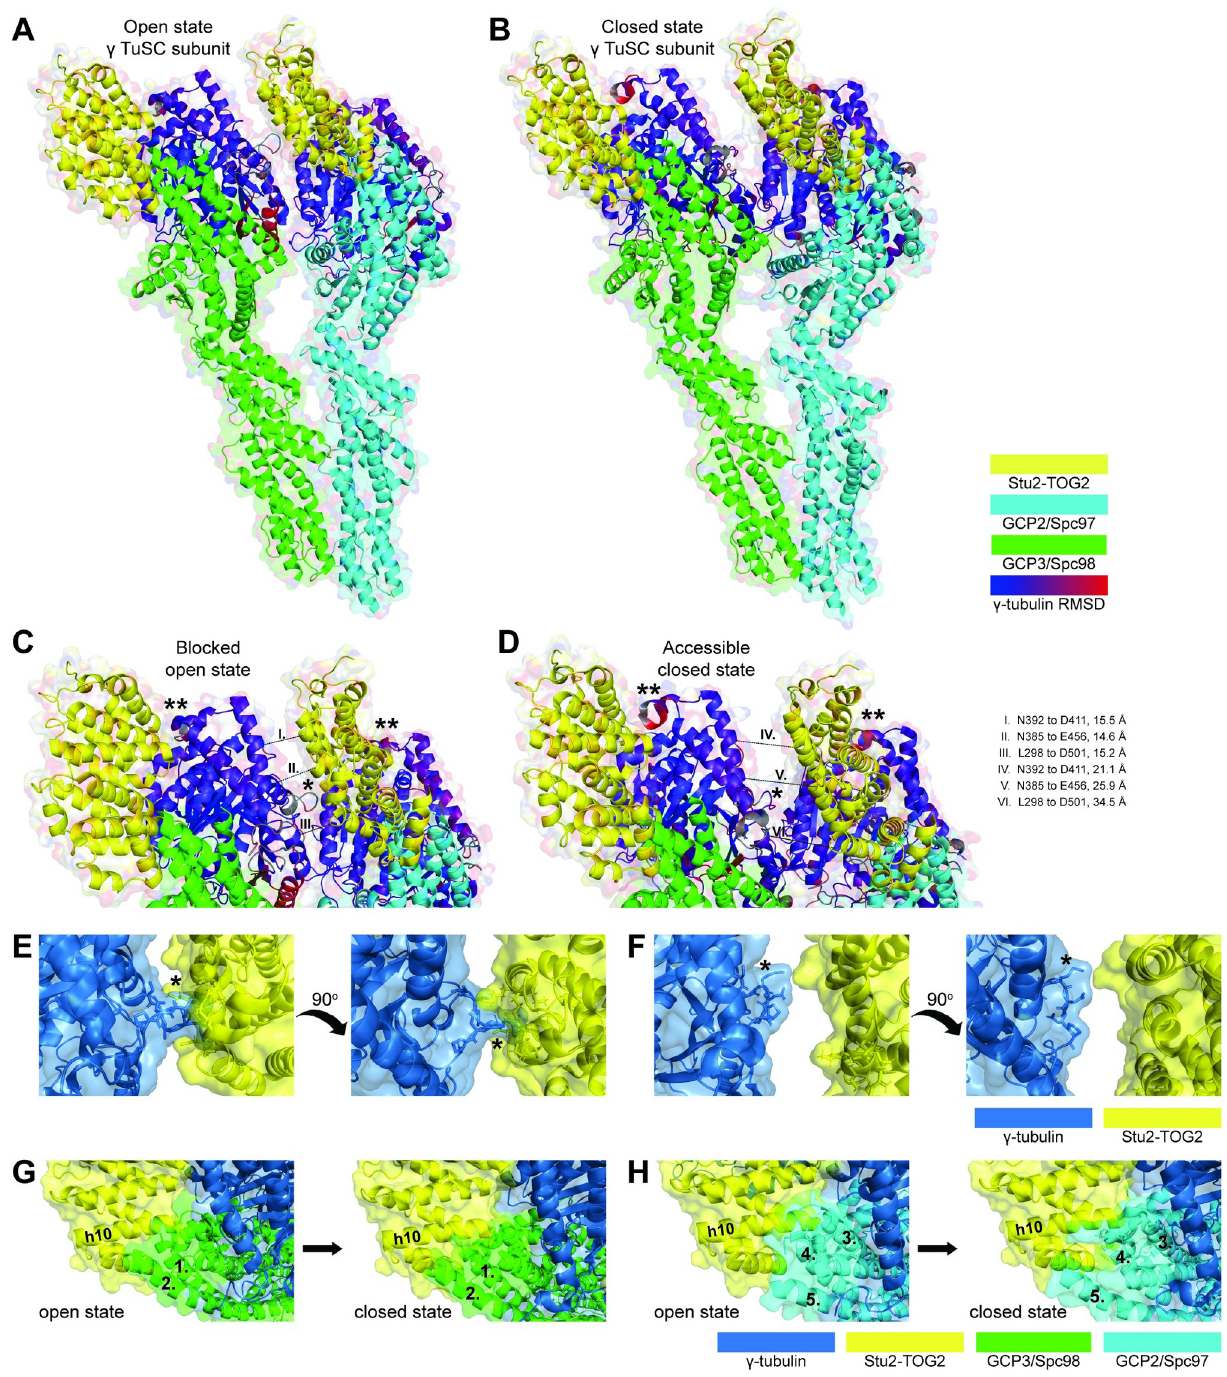
Fig 13. A composite model derived from cryo-EM and x-ray crystallography structures predicts that Stu2’s TOG interactions may be regulated by the open/closed conformational states of the γ -TuSC. A TOG bound γ -TuSC subunit is depicted in the (A) open state, adapted from pdb:5FM1 and pdb:4U3J, and (B) closed state, adapted from pdb:5FLZ and pdb:4U3J. A close-up view of the γ -TuSC complex in the (C) open state, and (D) closed state reveals SPB state dependent TOG domain accessibility. Distances between secondary amines of peptide backbones are reported in angstroms for the listed amino acids. A structured loop from the adjacent γ -tubulin projects into the space theoretically occupied by the Stu2 TOG2 domain in the open (E) but not the closed (F) confirmation γ -TuSC structure (marked with � in panels C-E). Stick structures are shown for γ -tubulin residues S307 through P313 and Stu2 TOG2 residues E456, L459, K460, R497, Y498, and E502. Relaxation of steric hindrance between TOG2 α -helix 10 of Stu2 and two α -helices of Spc98, corresponding to 1. aa Q756-L779 and 2. aa S798-D833, occurs as γ -TuSC undergo open to closed conformational changes (G). Relaxation of